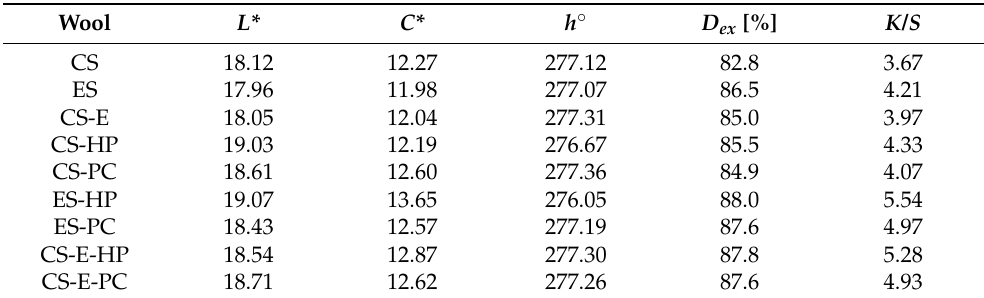
Table 6. Color parameters (L*, C*, h ◦ ), dye exhaustion ( D ex ) and color strength at 600 nm (K/S) of scoured and bleached wool fibers dyed with 3% owf Lanaset Navy